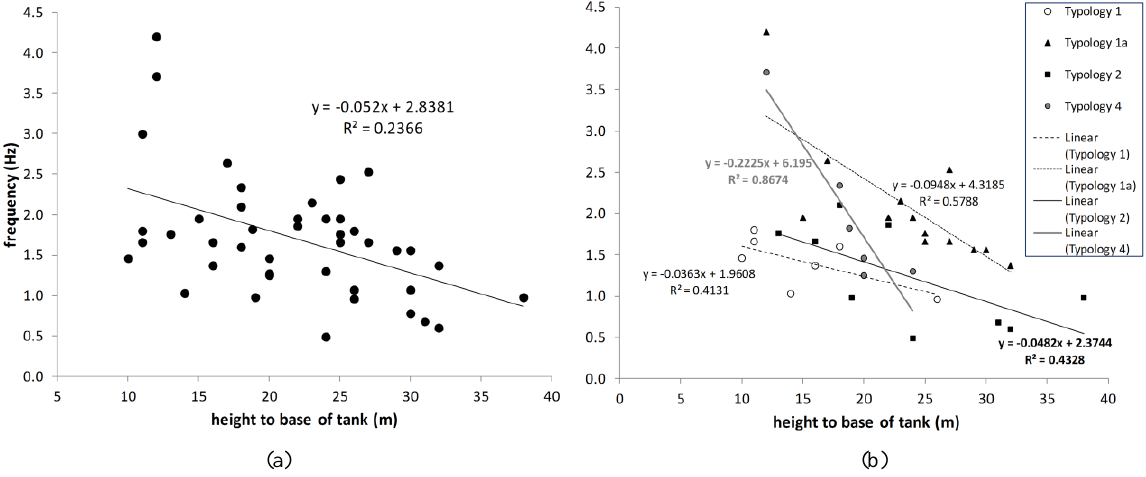
Fig. 4. Correlation of vibration frequency with tank height for the first mode: a) for all types; b) sorted by more significant typologies.